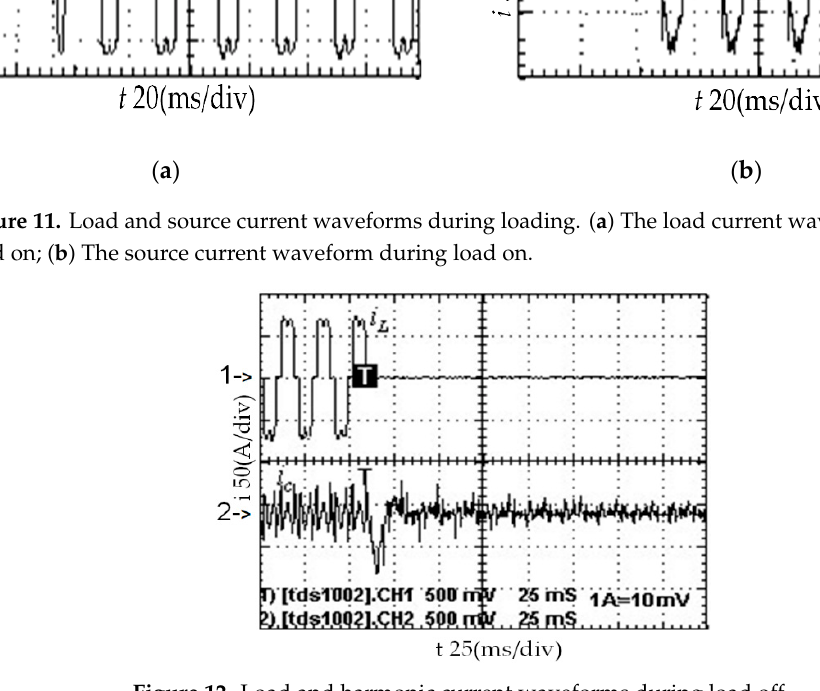
Figure 12. Load and harmonic current waveforms during load off.